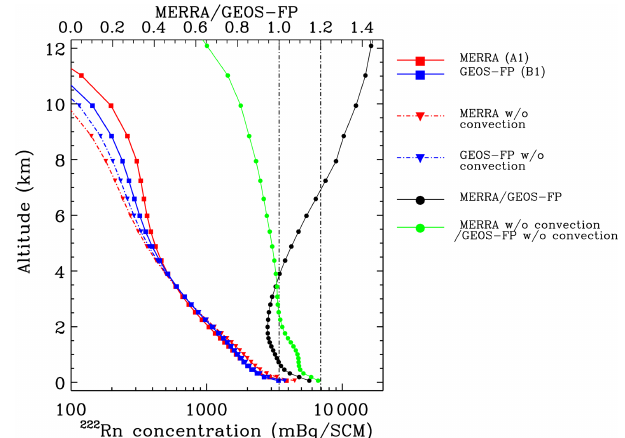
Figure 16. Annual zonal mean 222 Rn profiles (mBq/SCM, red and blue lines) averaged over land areas between 30–60 ◦ N latitudes in simulations driven by MERRA (A1 and A1-nc, Table 2) and GEOS- FP (B1 and B1-nc, Table 2), respectively. The black solid line (with the upper axis) shows the ratios of simulated 222 Rn concentrations in the standard simulations with MERRA and GEOS-FP. The green line shows the same ratios when convection is turned off in the sim- ulations. The two dotted–dashed black lines have constant ratios of 1.0 and 1.2,